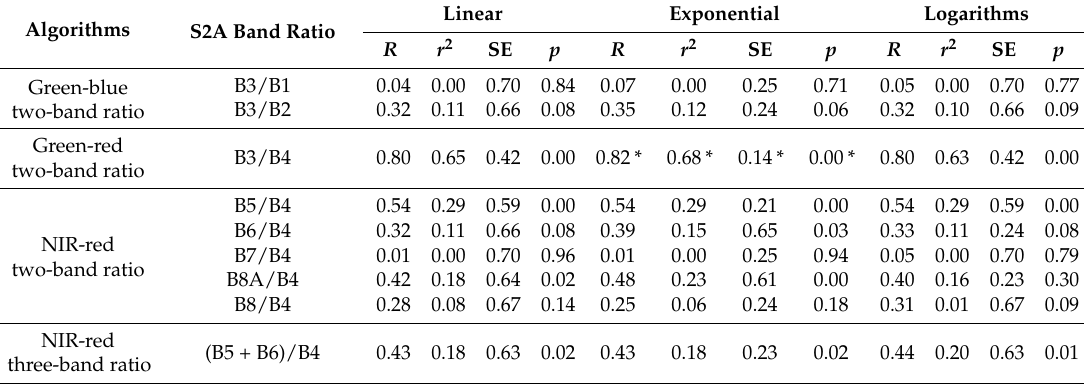
Table 2. Performances of selected Chla estimation algorithms and results of the best-fit curve analyses using in situ Chla and reflectance ( N = 30) measured concurrently on 26 June 2016 and 4 May